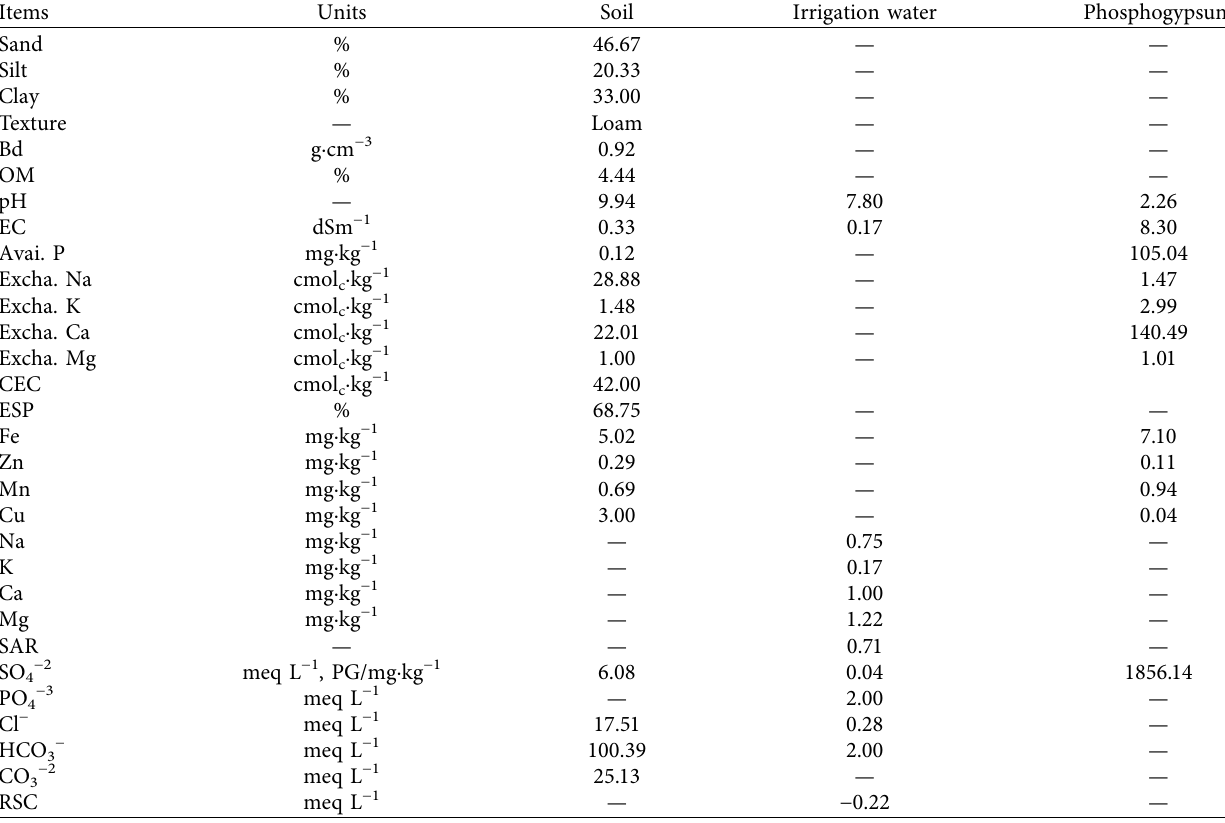
Table 1: Chemical analysis of soil (0–20cm depth), irrigation water, and PG used in the